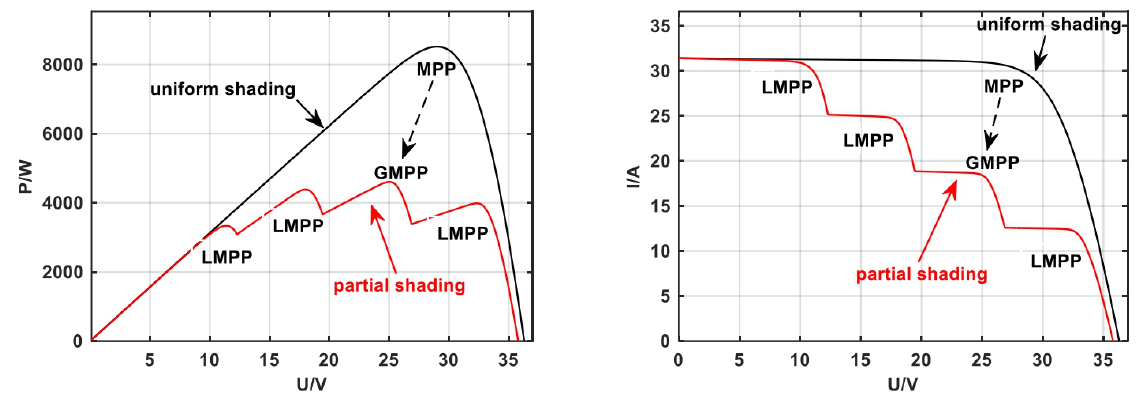
Fig. 2. P-V and I-V curves for the PV